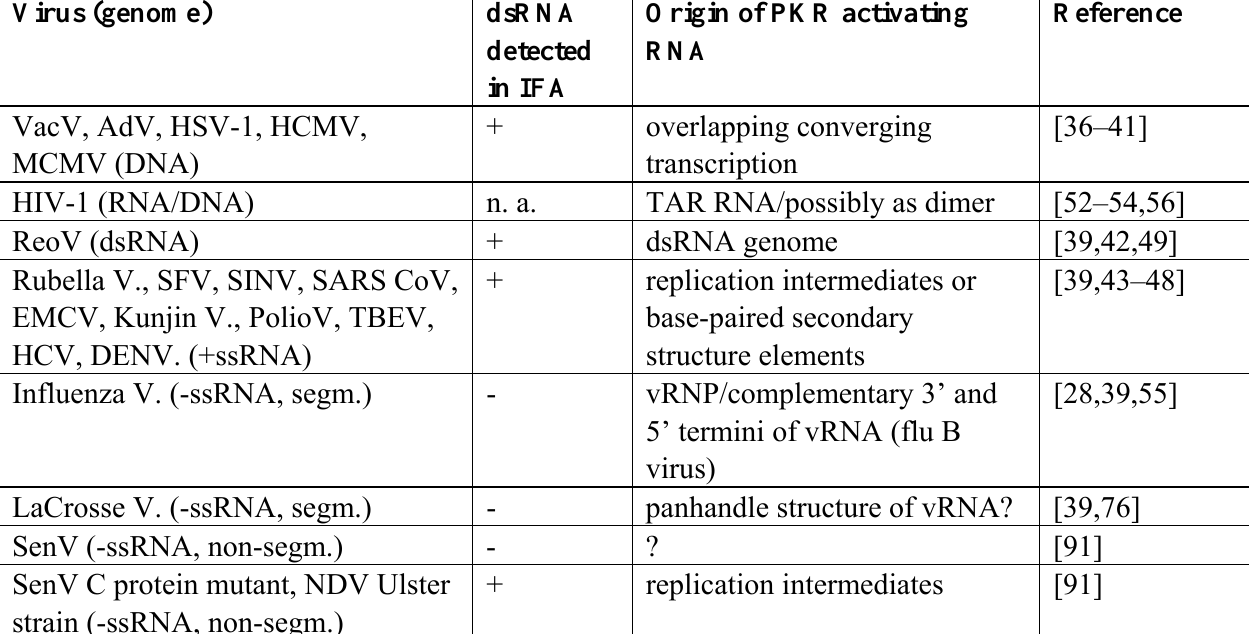
Table 1. Viral RNA structures that potentially activate